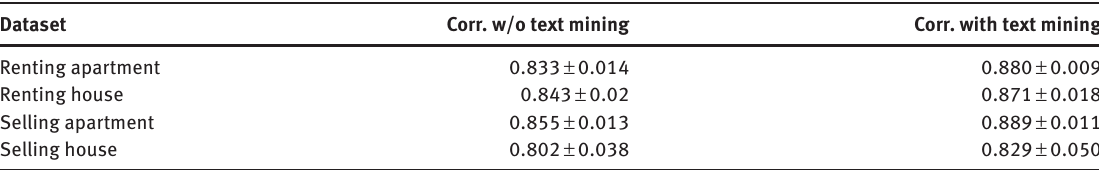
Table 8: Correlation (between Predicted and Actual Price) when SVMR Was Used in the First Stage of Our Two-Stage Regression Model. Dataset